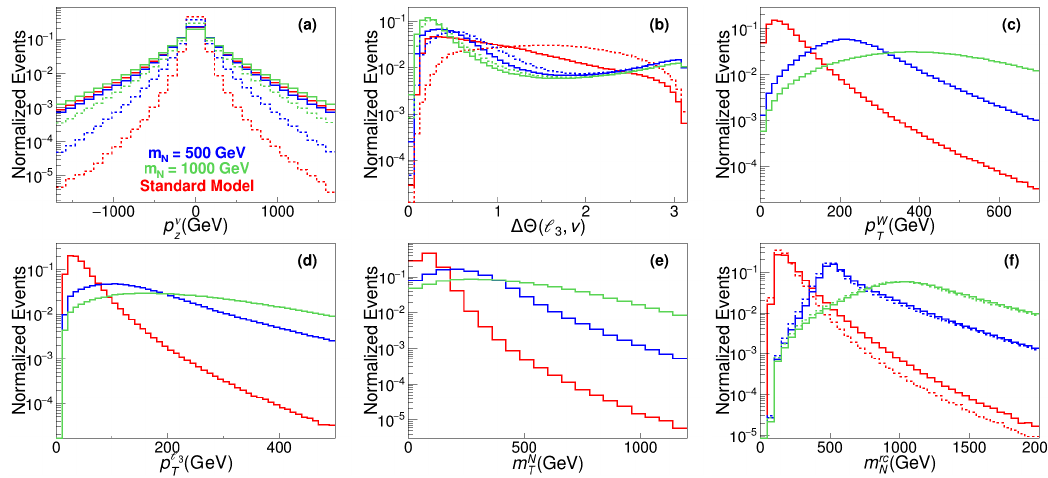
(upper left), ∆Θ( ‘ ) (upper middle), Figure 5 . Distributions of signal related observables p ν 3 , ν z (upper right), p ‘ 3 (lower left), m N (lower middle) and m rc (lower right) of SM backgrounds p W T T N T √ (red) and heavy neutrino signals with m = 500 GeV (blue) and 1000 GeV (green) at s = 14 TeV. N As the variable p ν is two-folded, the solid lines in the upper left, upper middle and lower right z panels correspond to the solution 0 (larger absolute value of p ν ) and the dash lines to the solution 1 z (smaller absolute value of p ν ). The distributions are normalised so that their integrals are equal to z